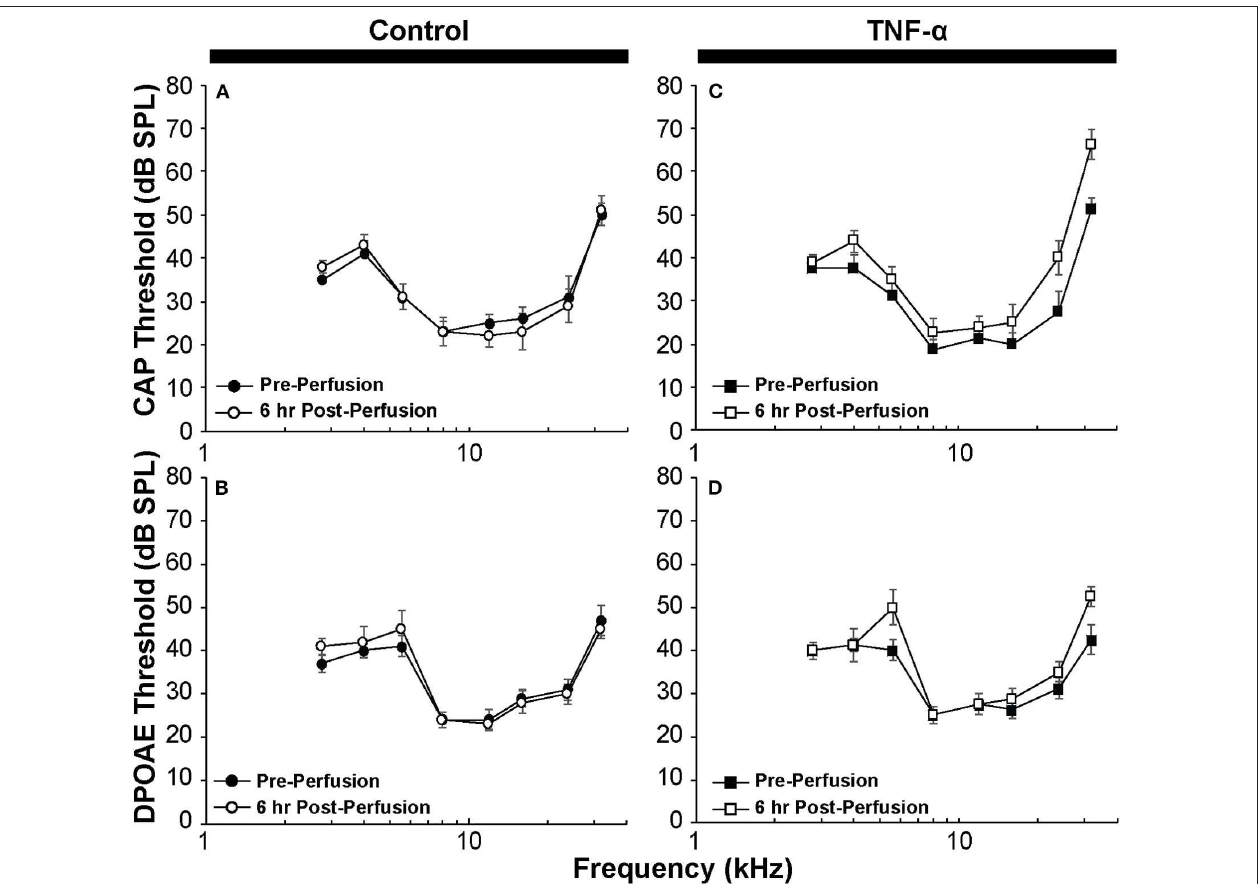
FIGURE 2 | (A) CAP thresholds and (B) DPOAE thresholds in control guinea pig before vs. 6h after perfusion of artificial perilymph through scala tympani demonstrate minimal impact of the surgical and perfusion techniques; N = 5 animals. (C) CAP thresholds and (D) DPOAE thresholds in the TNF- α group before vs. 6h after intracochlear perfusion of TNF- α ; N = 4 animals. Error bars represent standard errors of the mean. Differences in thresholds were not statistically significant ( p >